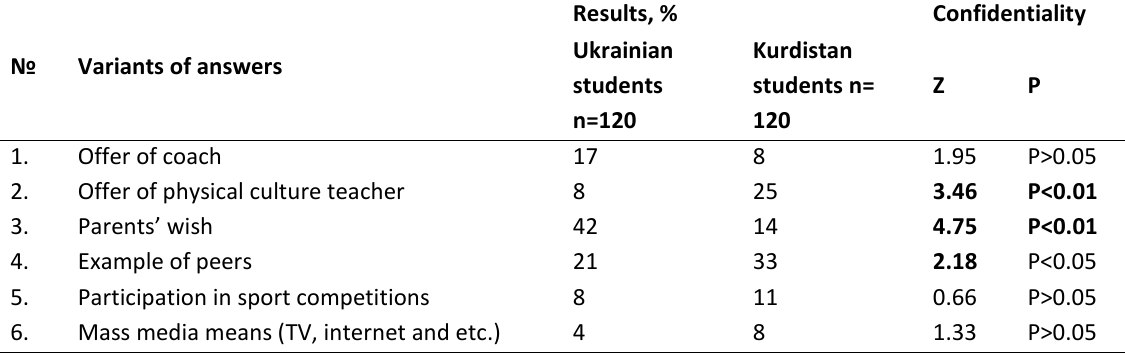
Table1. Reasons, which facilitate starting of sports practicing by specialized HEEs students of Ukraine and Kurdistan